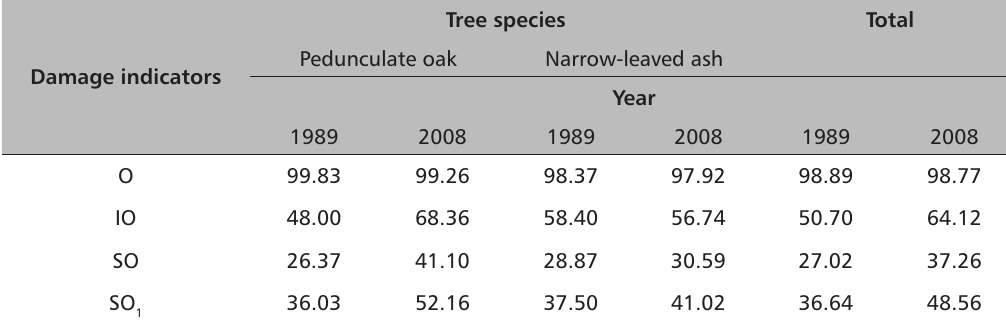
TABLE 2. Damage indicators for Josip Kozarac management unit (aerial survey in 1989 and 2008) Tree Damage indicators